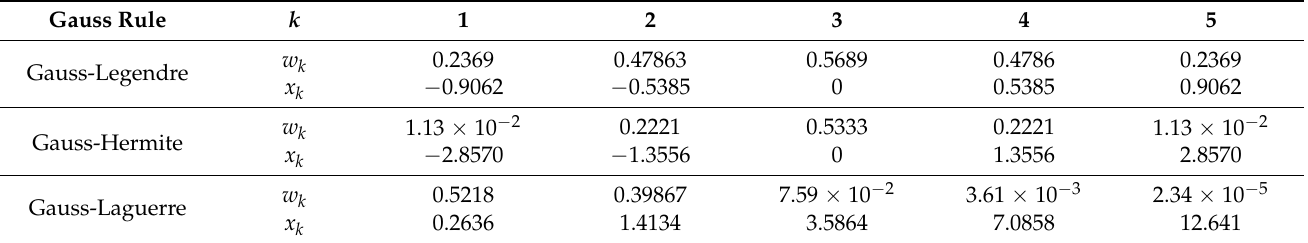
Table 1. Some commonly used Gauss points and its weight for Gauss